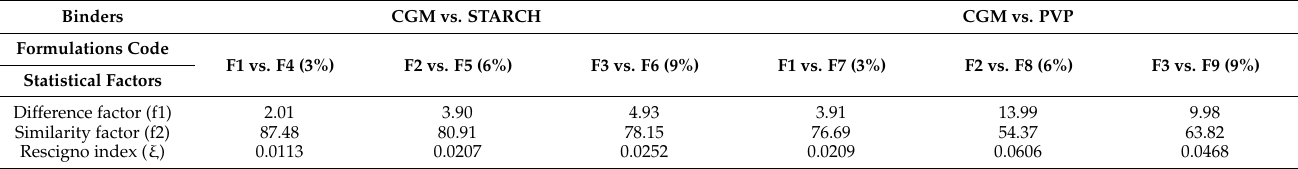
Table 11. Statistical factors of CGM compared with STARCH and PVP as binding